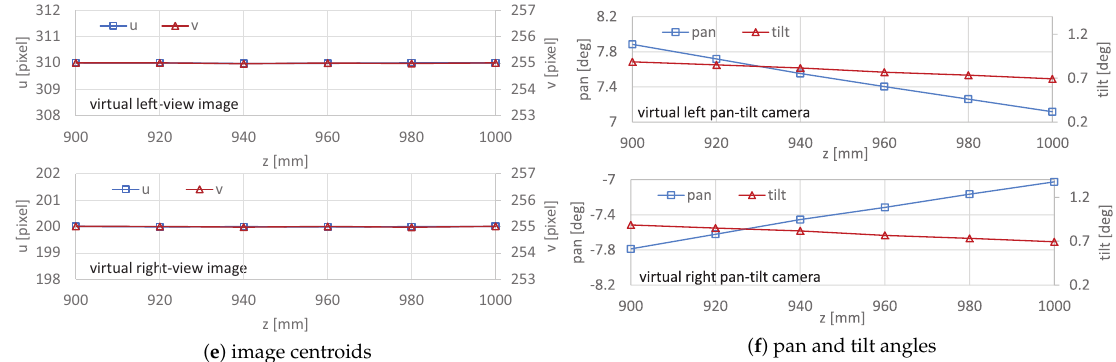
Figure 11. Measured 3D images and positions, image centroids, and pan and tilt angles of virtual left and right pan-tilt cameras for stationary 3D scenes at different depths: ( a ) left-view images; ( b ) right-view images; ( c ) measured 3D images; ( d ) measured 3D positions; ( e ) image centroids; ( f ) pan and tilt